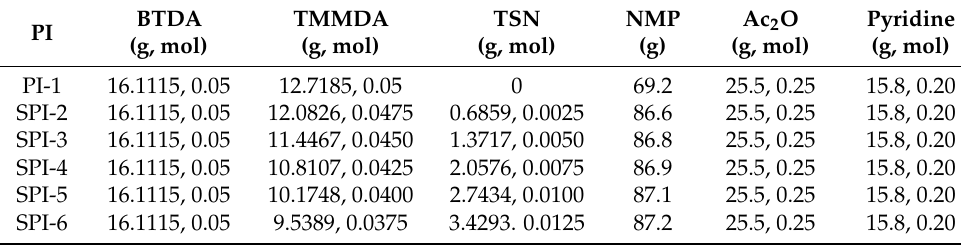
Table 1. Formula for the PI and SPI